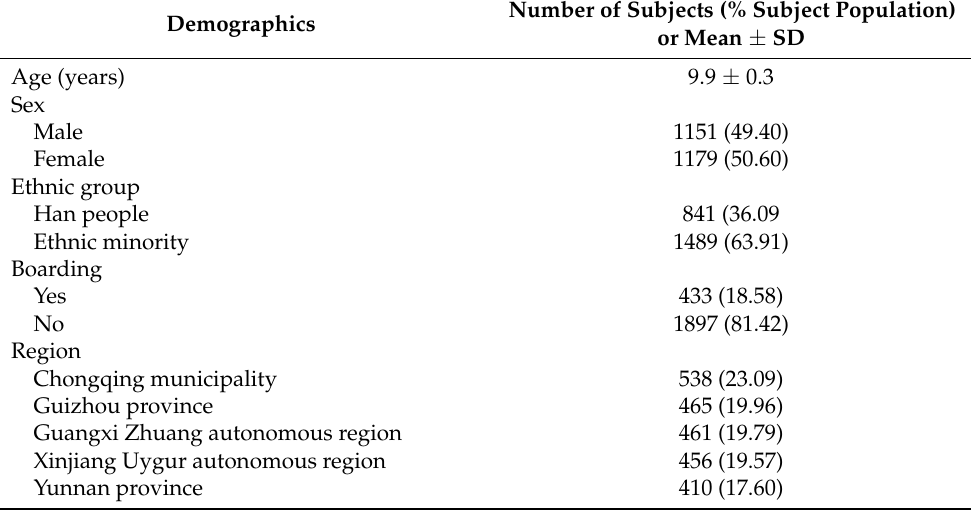
Table 1. Demographics of study participants (N =